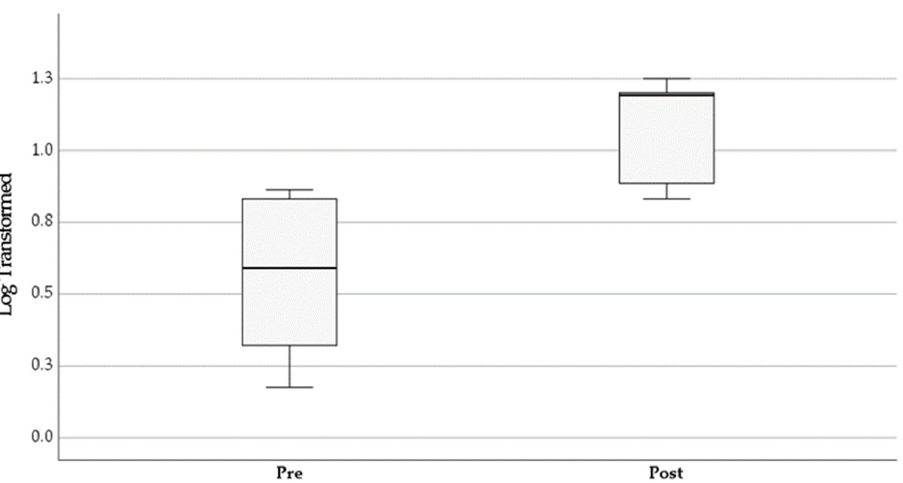
Figure A3. Box plot showing changes in the mean salivary cortisol concentrations for beaver dam breaking.